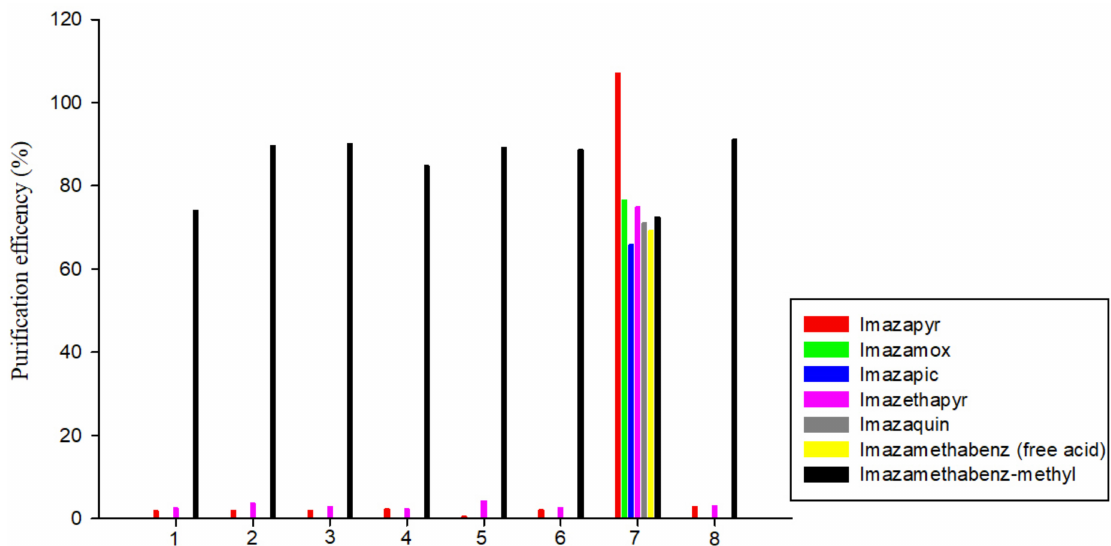
Figure 2. Efficiency of eight purification adsorbents (1; 50 mg PSA, 50 mg C 18 , 50 mg GCB, 2; 25 mg PSA, 50 mg GCB, 3; 50 mg PSA, 4; 50 mg PSA, 50 mg GCB, 5; 25 mg PSA, 25 mg GCB, 6; 50 mg PSA, 50 mg C 18 , 7; 25 mg C 18 , 8; 25 mg PSA, 25 mg C 18